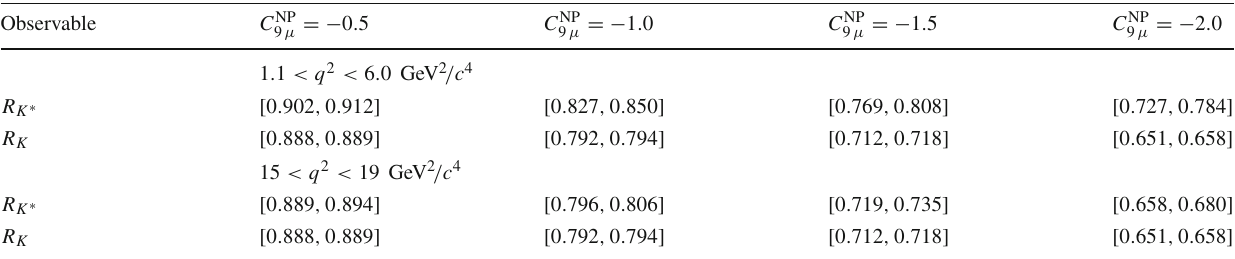
remaining CP -averaged observables in the SM using the expected post-fit precision of the long-distance parameters (cid:16) C total at the end of Run2 of the 9 λ LHC. A sample of O ( 10 6 ) simulated B 0 → K ∗ 0 μ + μ − decays that include contributions from both short- and long-distance components, is used to determine the parameters of (cid:16) C total . The 9 λ decays are simulated in the SM, with the parameters θ 0 , ζ λ and j ω λ set to zero. The 68% confidence intervals are shown for the statistical uncertainty (cyan band) and the combination of the statistical uncertainty with the B → K ∗ form-factor uncertainties (magenta band) given in Ref. [15]